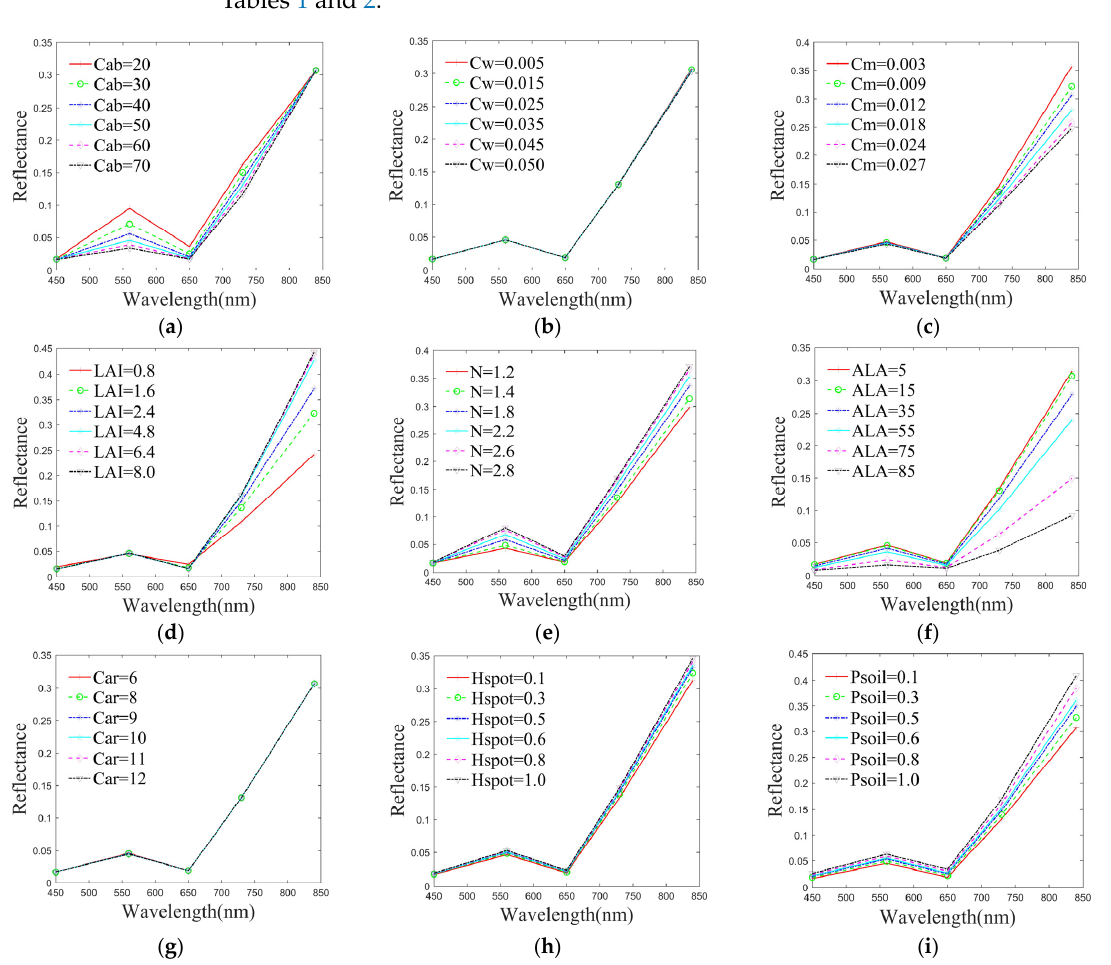
Figure 5. Spectral response under different input parameter values. ( a – d ) are the different reflectance changes of physicochemical parameters Cab, Cw, Cm and LAI, respectively. ( e , f ) are the difference reflectance changes of structure parameter N and geometry parameter ALA, respectively. ( g – i ) are the difference reflectance changes of parameters Car, Hspot and Psoil,